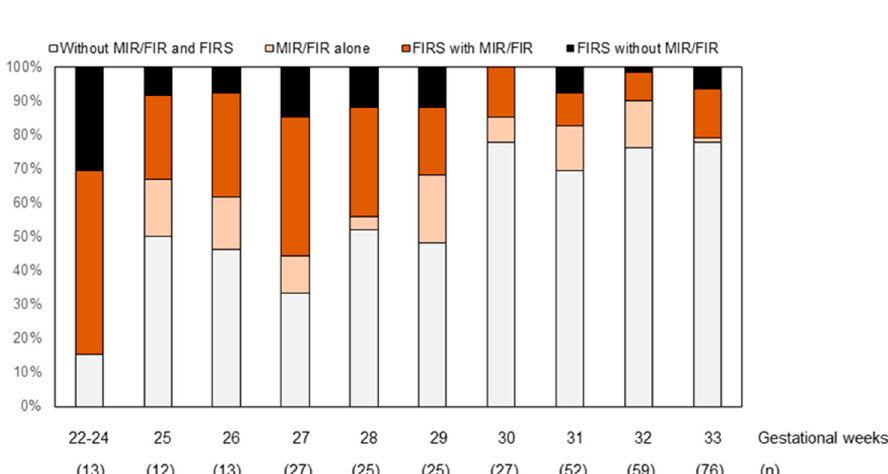
Figure 2. Incidence of FIRS with or without MIR/FIR according to gestational age. Abbreviations: FIRS, fetal inflammatory response syndrome; MIR, maternal inflammatory response; FIR, fetal inflammatory response.